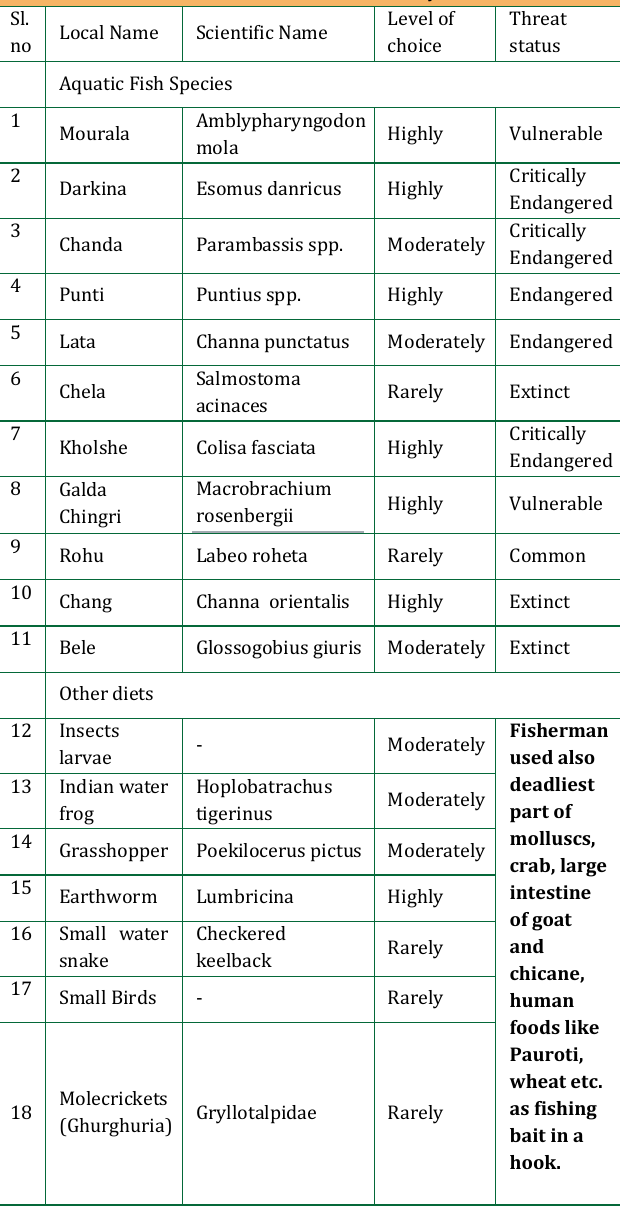
Table 1: The list of fishing baits and the scientific name of aquatic species with their threat status used by fisherman for caching Attu fish from river by fishing rod. Choice of food of Attu fish also presents with considerable scale recommended by fisherman.